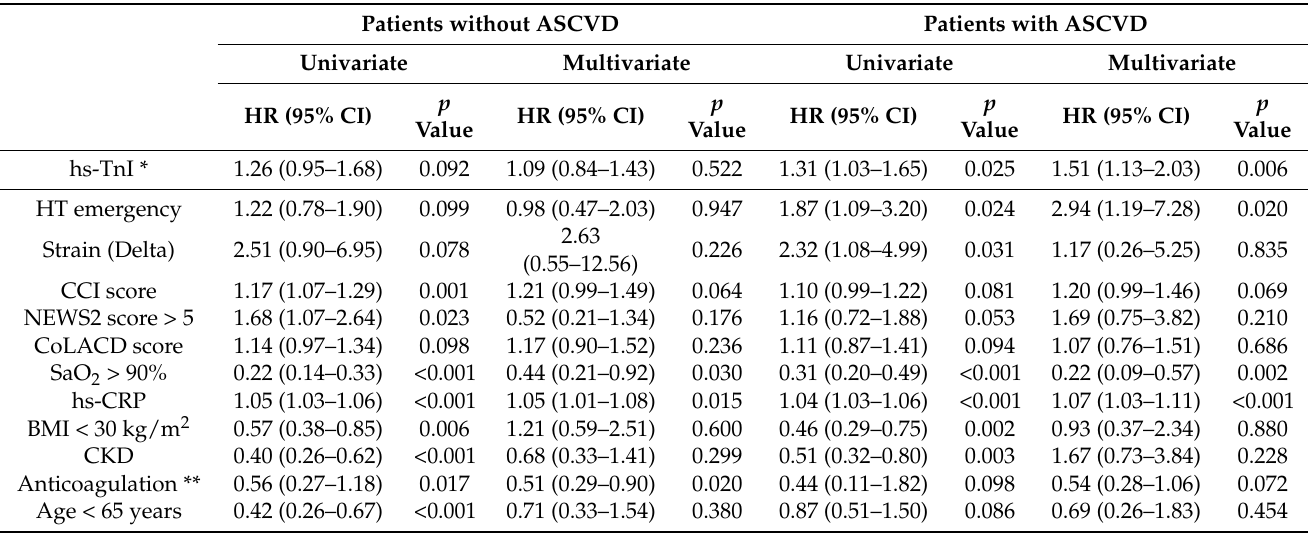
Table 4. Cox proportional hazards model assessing the relationship between admission high- sensitivity troponin I and the main outcome adjusted for multiple relevant covariates, in relation with history of ASCVD.